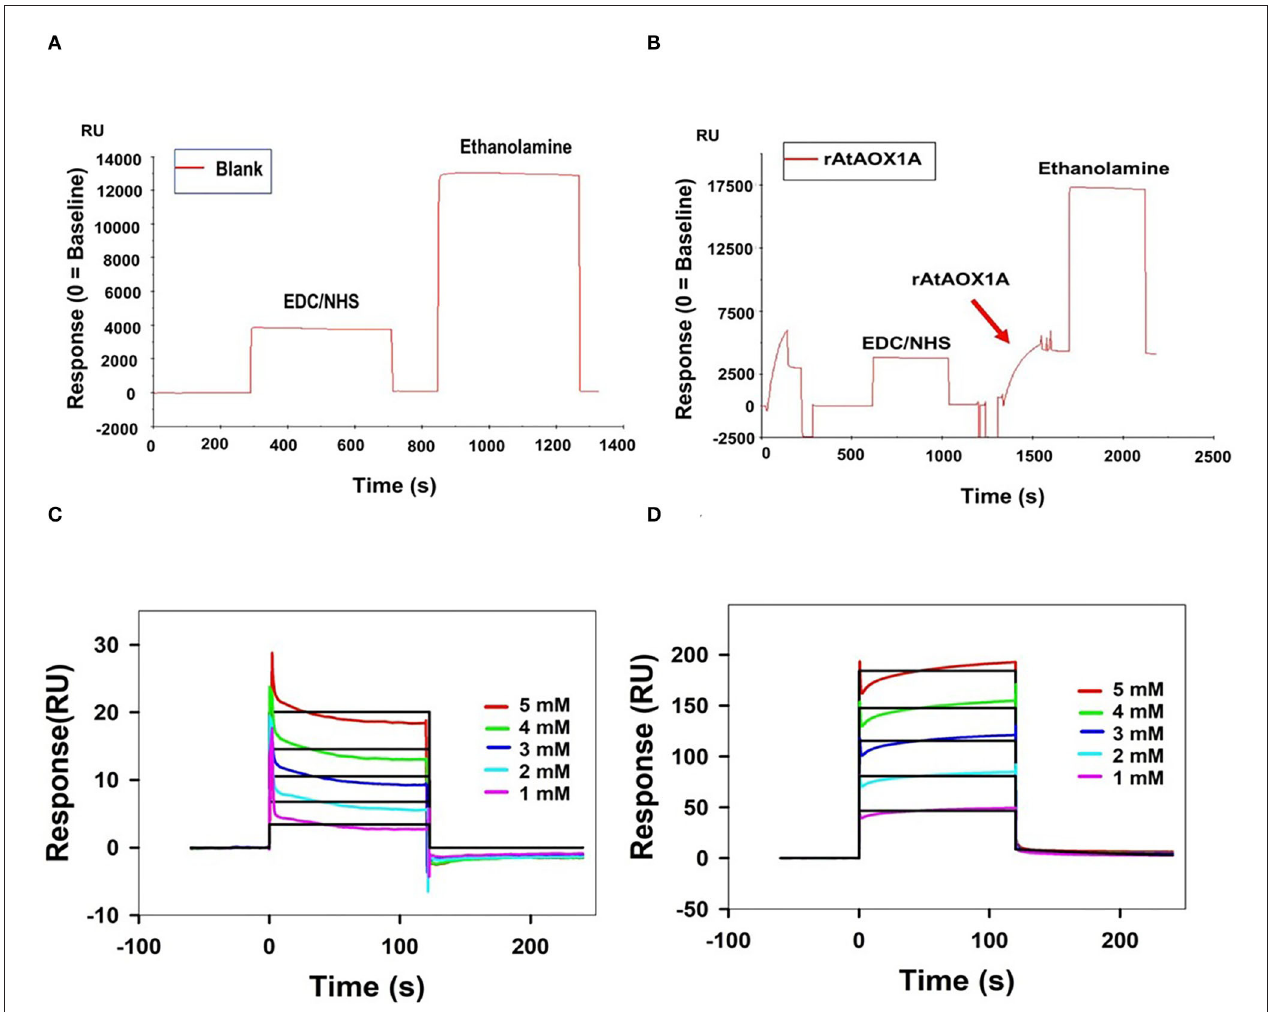
FIGURE 5 | Purified rAtAOX1A is immobilized onto Series S Sensor Chip CM5. (A) Blank immobilization on flow cell Fc-3; (B) 100 µ g/ml of purified rAtAOX1A (ligand) immobilization on flow cell Fc-4. Arrow indicates rAtAOX1A injection, which resulted in ∼ 4,117 RU. SPR kinetics of SHAM and n-PG with rAtAOX1A: (C,D) Binding curves for SHAM and n-PG with rAtAOX1A at 25 ◦ C. The colored lines represent the concentrations of SHAM/n-PG (1, 2, 3, 4, and 5mM), the black lines correspond to the fit lines to the data, and each fit line is a result of a global fit. The final sensorgram is representative of three